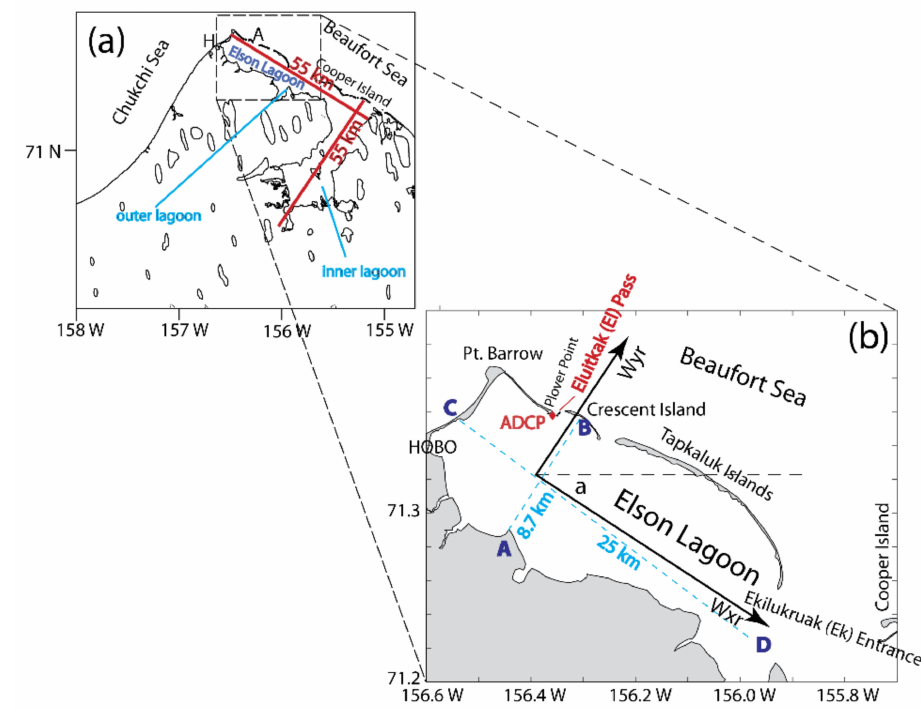
Figure 2. Study area at the northwestern Alaska between the Chukchi Sea and Beaufort Sea ( a ). The zoomed-in view of the Elson Lagoon ( b ) which also shows the scales and the location of bottom- mounted ADCP at the Plover Point at Eluitkak Pass.